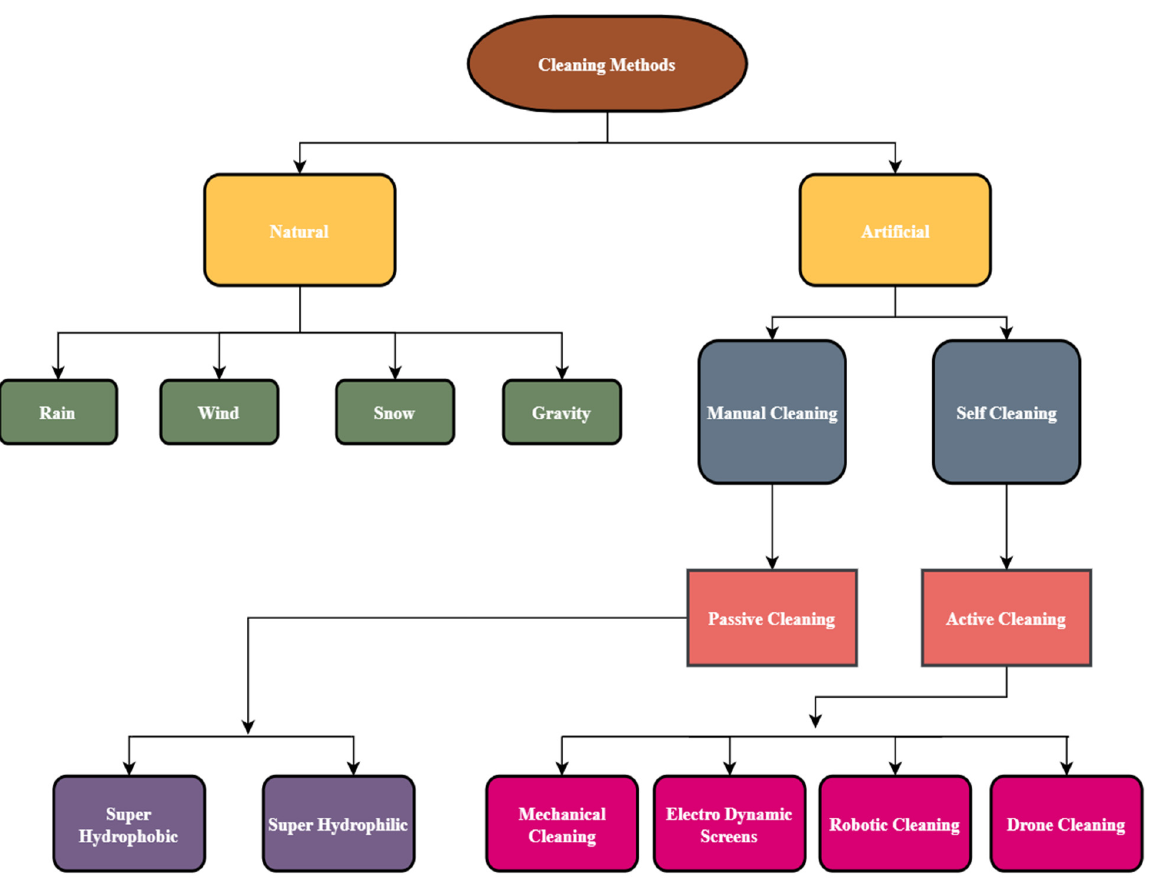
Figure 27. Flowchart of different cleaning techniques.